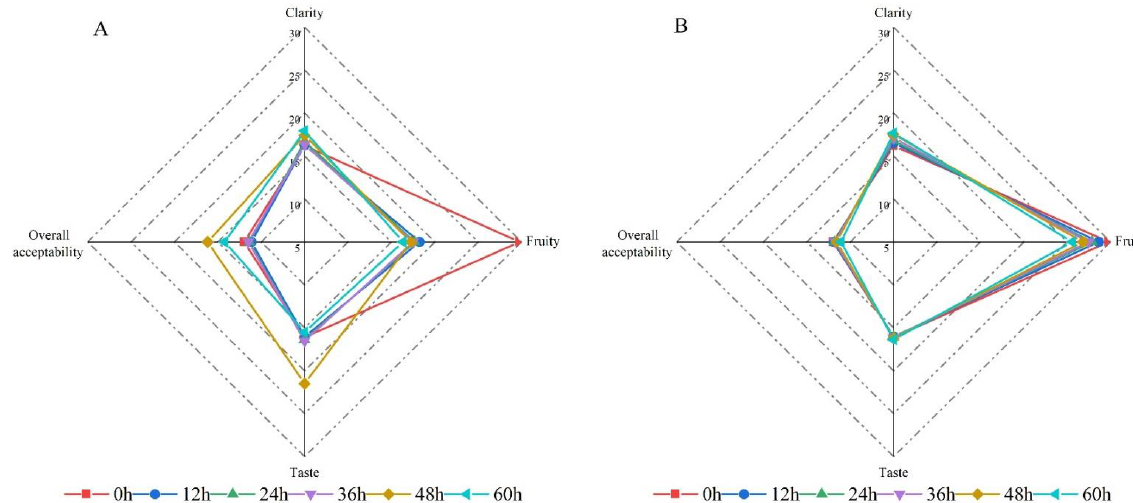
Figure 3. Radar plot showing sensory evaluation of fermented ( A ) and control ( B ) lemon juice.